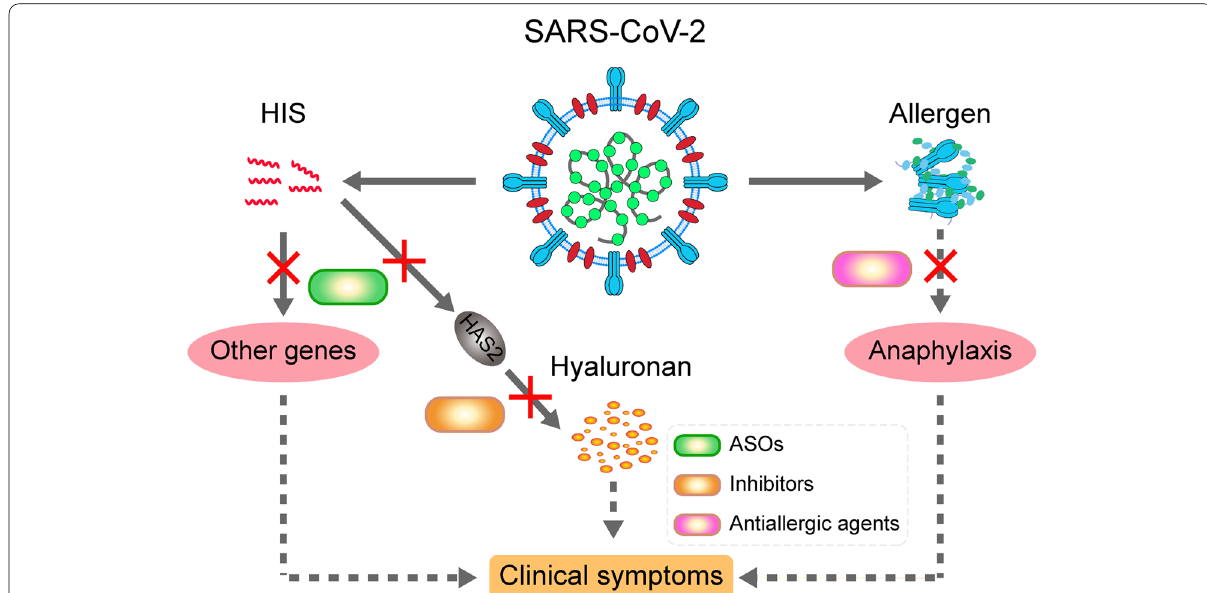
Fig. 5 The potential strategies for COVID-19 therapy. There are two potential approaches to cause the clinical symptoms of COVID-19. In one hand, the generation of HIS from SARS-CoV-2 could activate inflammation-related genes (such as HAS2 ) and induce the production of hyaluronan. On the other hand, the spike protein of SARS-CoV-2 could trigger the allergic reaction in some individuals with COVID-19. Accordingly, we could use antisense oligonucleotides (ASOs) of HIS-SARS2, inhibitors of hyaluronan synthesis, and antiallergic agents to block these approaches and thereby facilitate the recovery of clinical symptoms in